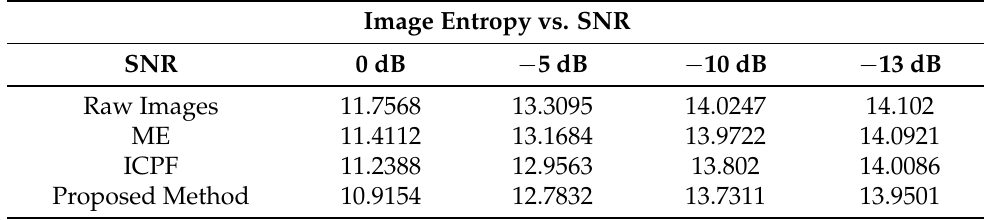
Figure 11. Experimental results of TG-I electromagnetic simulation under different SNRs. Table 7. Entropy of high-speed compensated images with different SNRs based on TG-I’s EM simulation